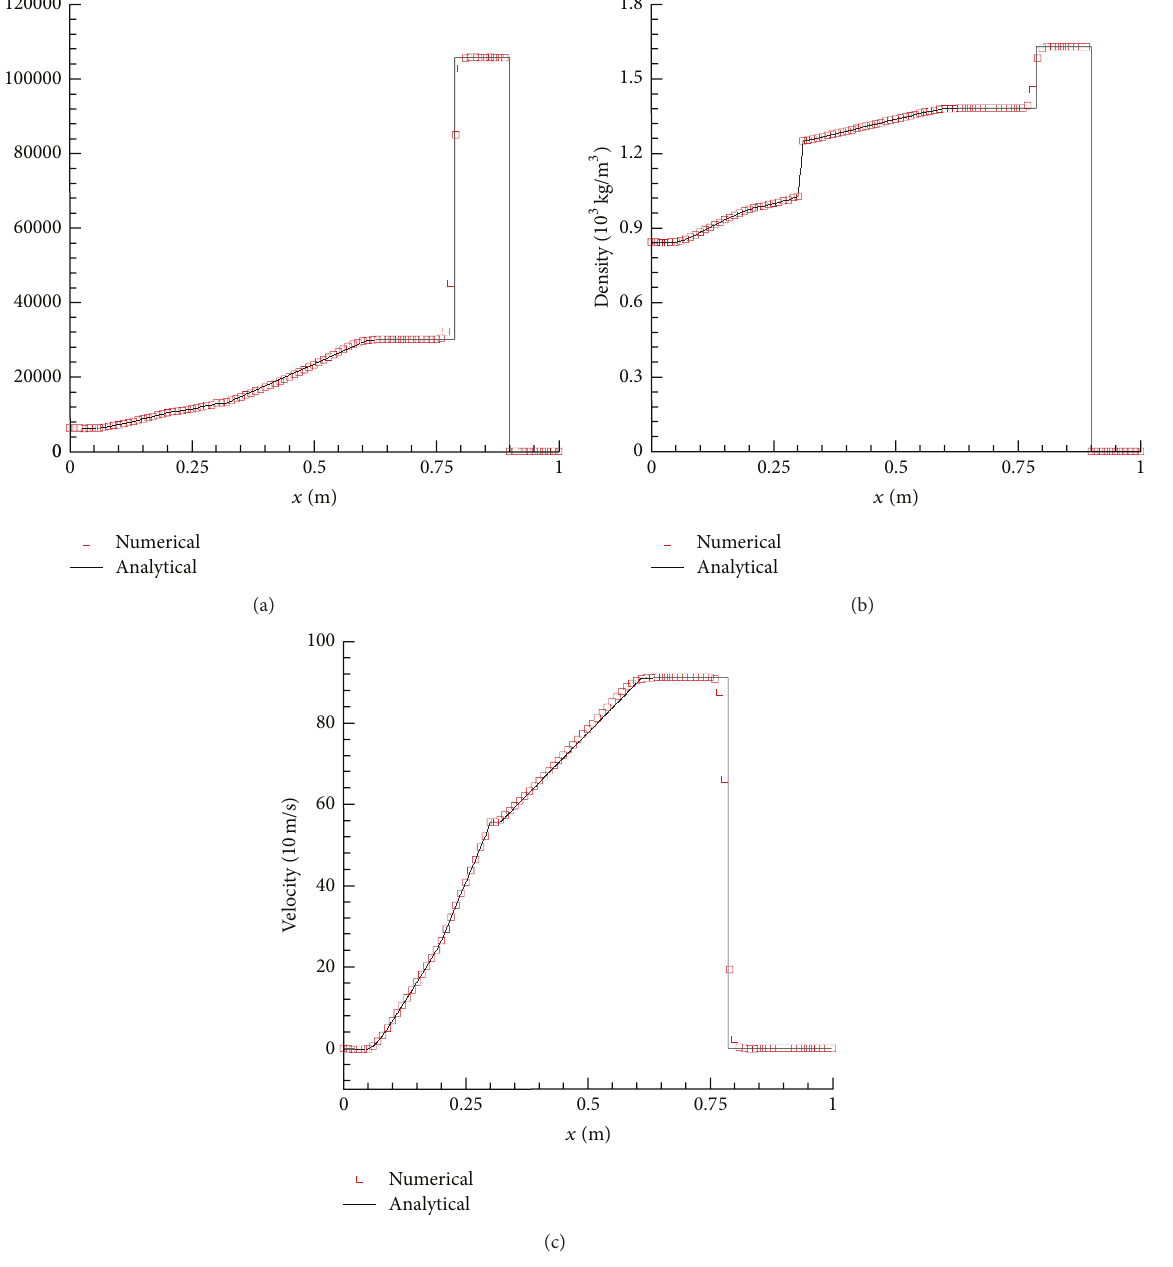
Figure 7: Numerical results by GFM-based algorithm at 𝑡 = 19.79 ms (Case